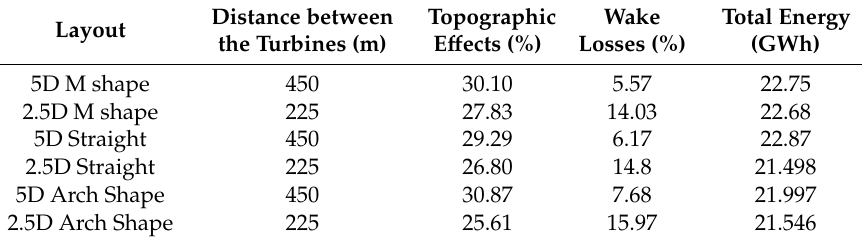
Table 1. Summary of the wind turbines arrangement.